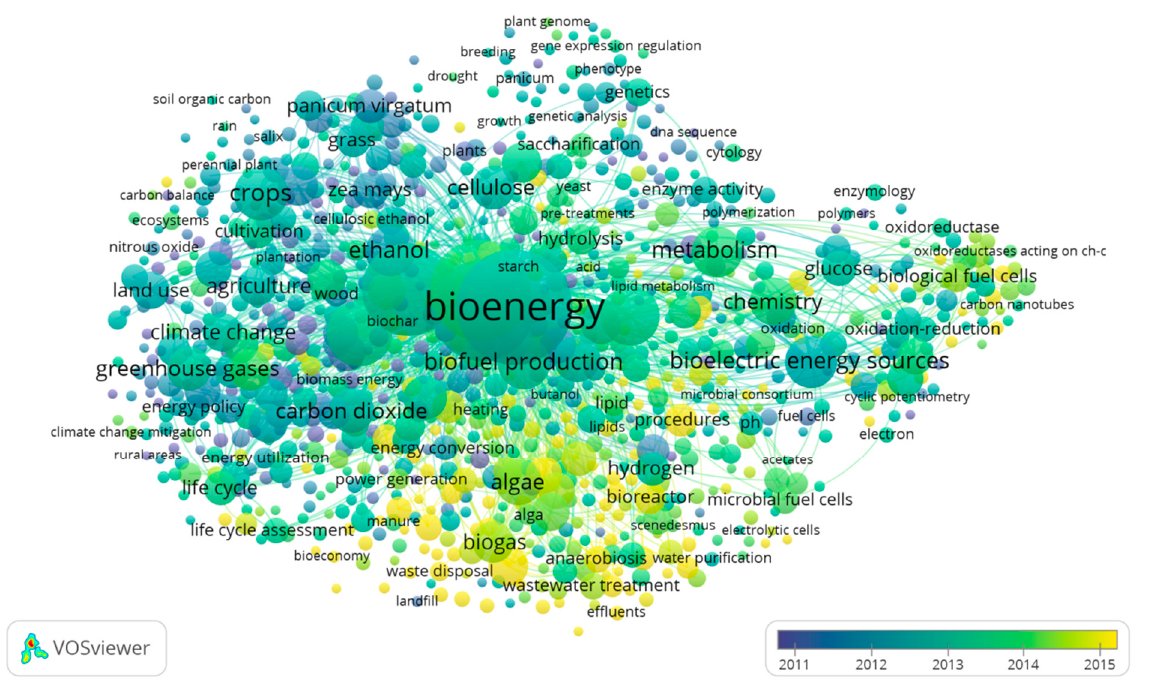
Figure 6. Results of bibliometric analysis of chronology of keywords occurrence in the scientific research on the request “bioenergy” + “biofuel”.